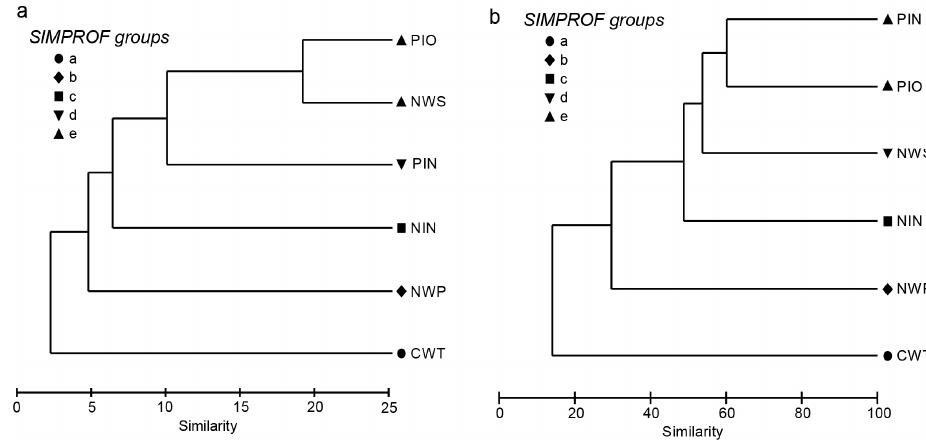
Figure 5. Cluster analyses of similarities between sponge communities in the study area (Pilbara region) and corresponding Jaccard similarity index at the ( a ) species and OTU level and ( b ) genus level. PIN–Pilbara Nearshore, PIO–Pilbara Offshore, NIN–Ningaloo, NWS–Northwest Shelf, NWP– Northwest Province and CWT–Central West Transition.